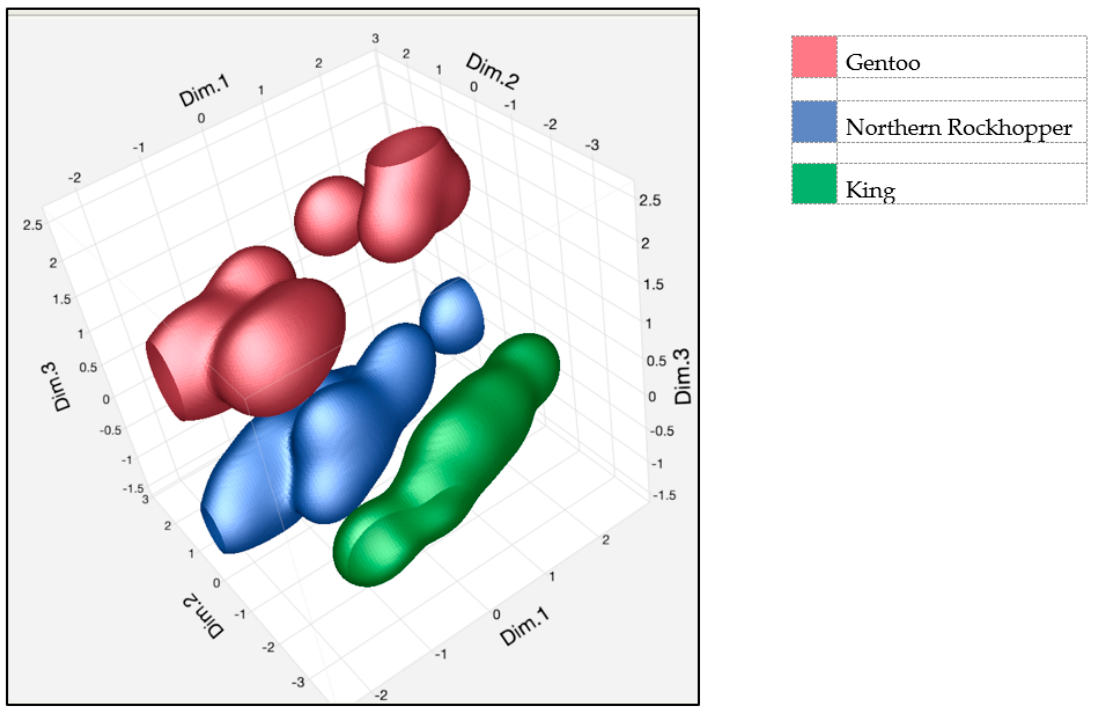
Figure 5. 3D graph reporting the three dimensions and the 90% nonparametric confidence interval. It is evident how the three species clusterize and differentiate themselves gravitating around different key personality traits.